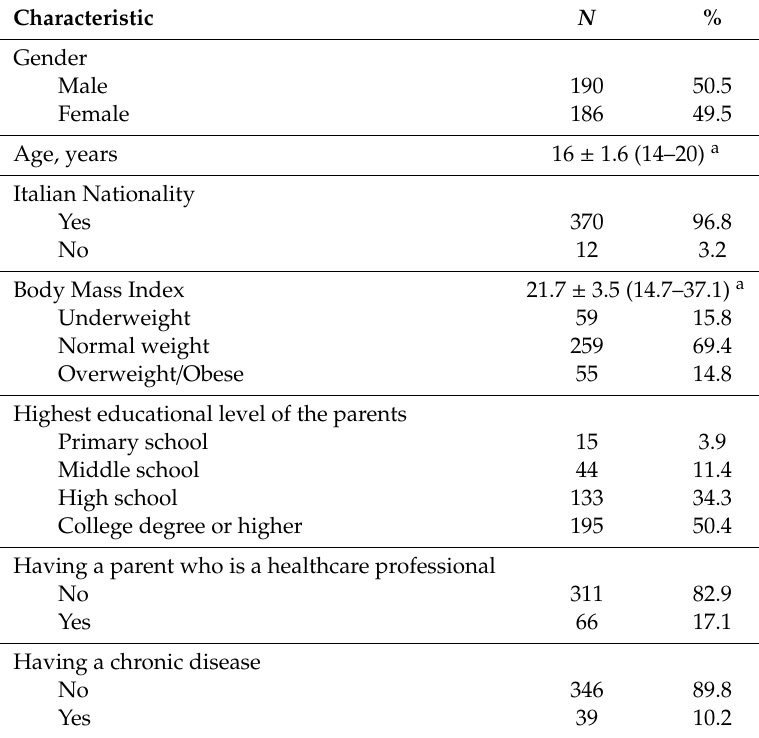
Table 1. Main characteristics of the study